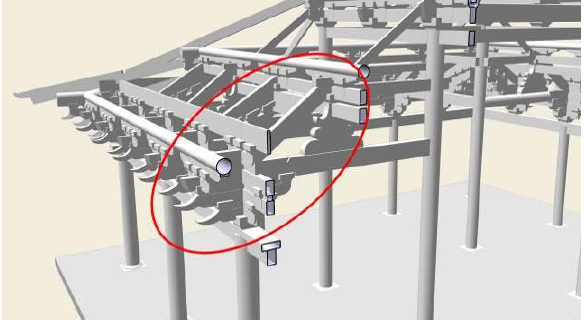
Figure 5 Brackets we called “dou gong” are consist of a group of component. It transmit gravity force of roof to column.